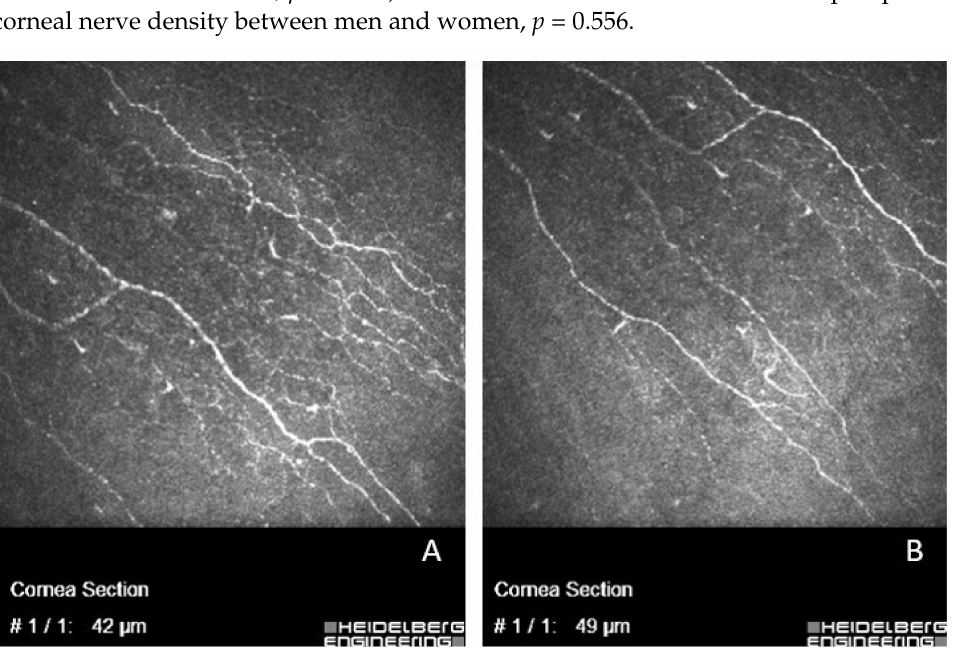
Figure 2. Corneal subbassal nerve plexus before ( A ) and 1 month after the cataract surgery ( B ), the same